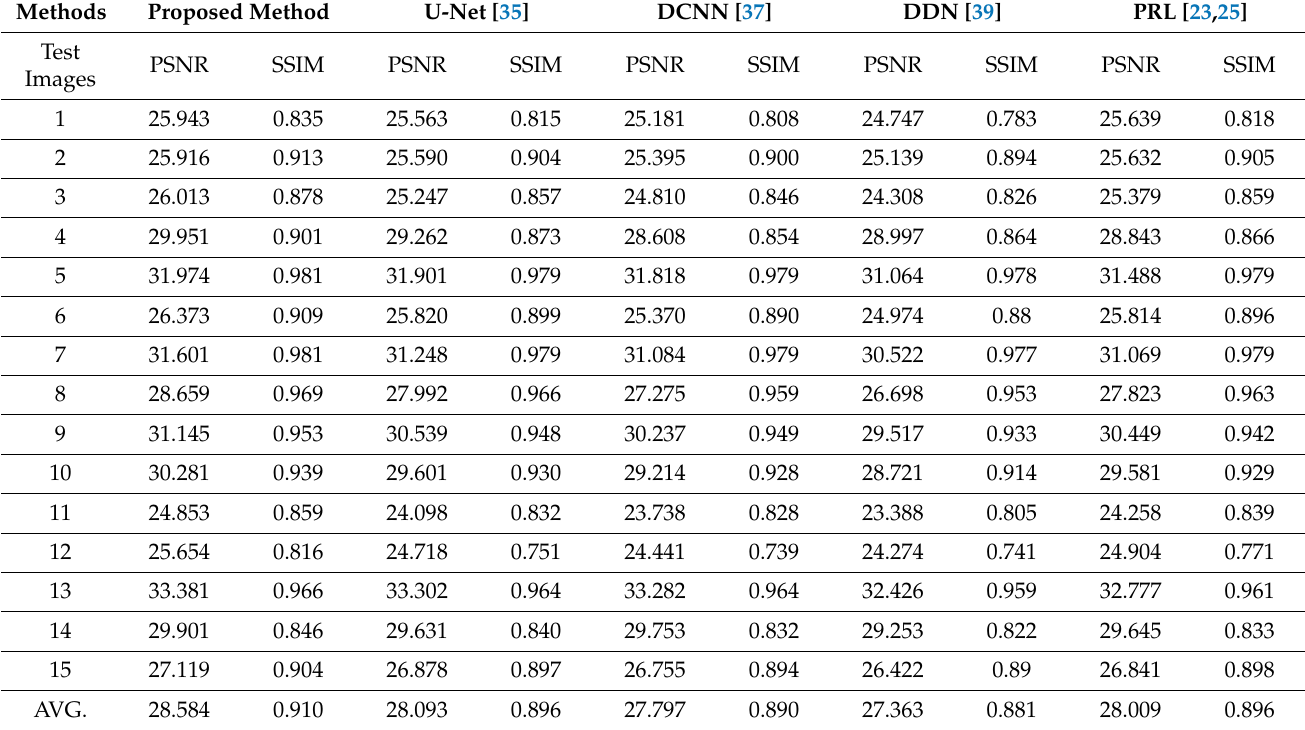
Table 2. Performance evaluation for the small texture dataset.